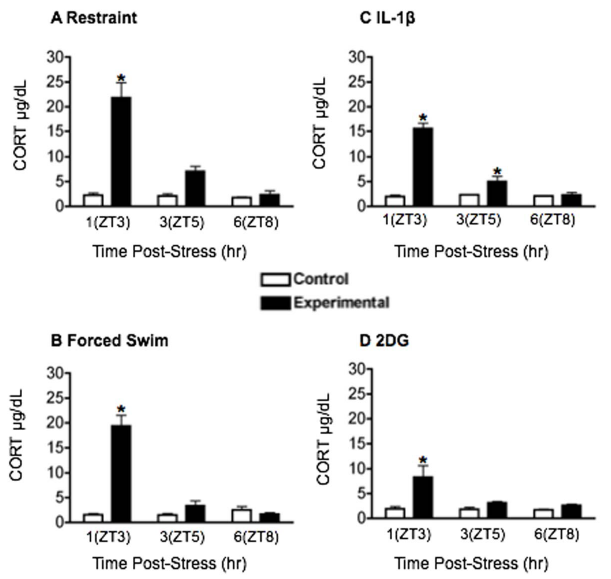
Figure 1. The effect of stress on plasma corticosterone (CORT). Plasma CORT levels in control and stressed (experimental) rats following A ) 30 min restraint B ) 15 min forced swim C ) treatment with 5 m g/kg IL-1 b D ) treatment with 250 mg/kg 2DG. Means 6 SEM are shown, n =4 per group; * significant difference from corresponding control group, p , 0.05.